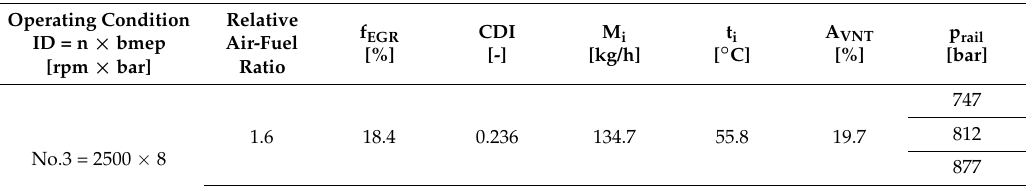
Table 8. Schedule of experimental activities for test Set 4 and average values of operating parameters (operating condition